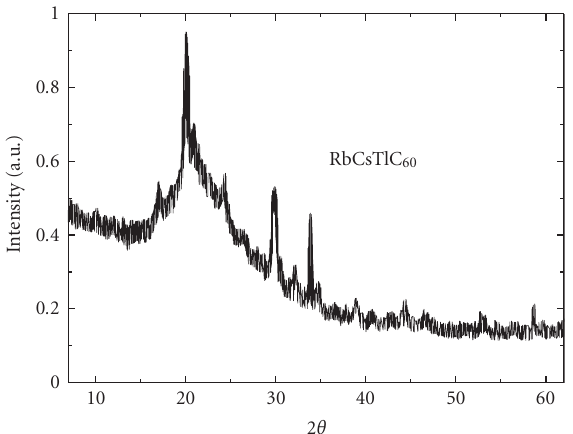
Figure 3: Di ff ractogram of fulleride RbCsTlC 60 synthesized by (4) mixed with the product of reaction